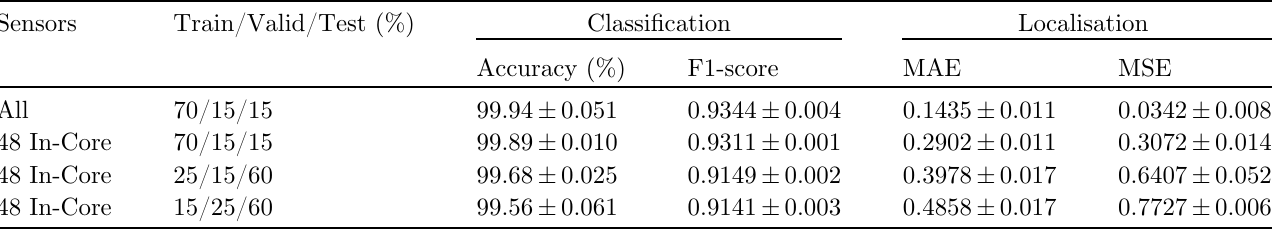
Table 1. Results of the proposed 3D-CNN for the classi fi cation and localisation of perturbation type and source location ( i, j, k ). Mean and standard deviation of 3 runs.